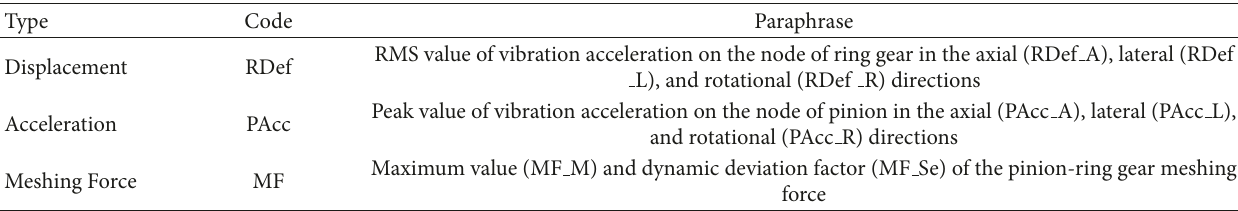
Table 3: Outputs for evaluating the dynamic